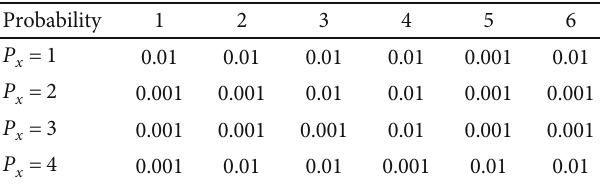
Table 4: Energy release and gas concentration over the standard